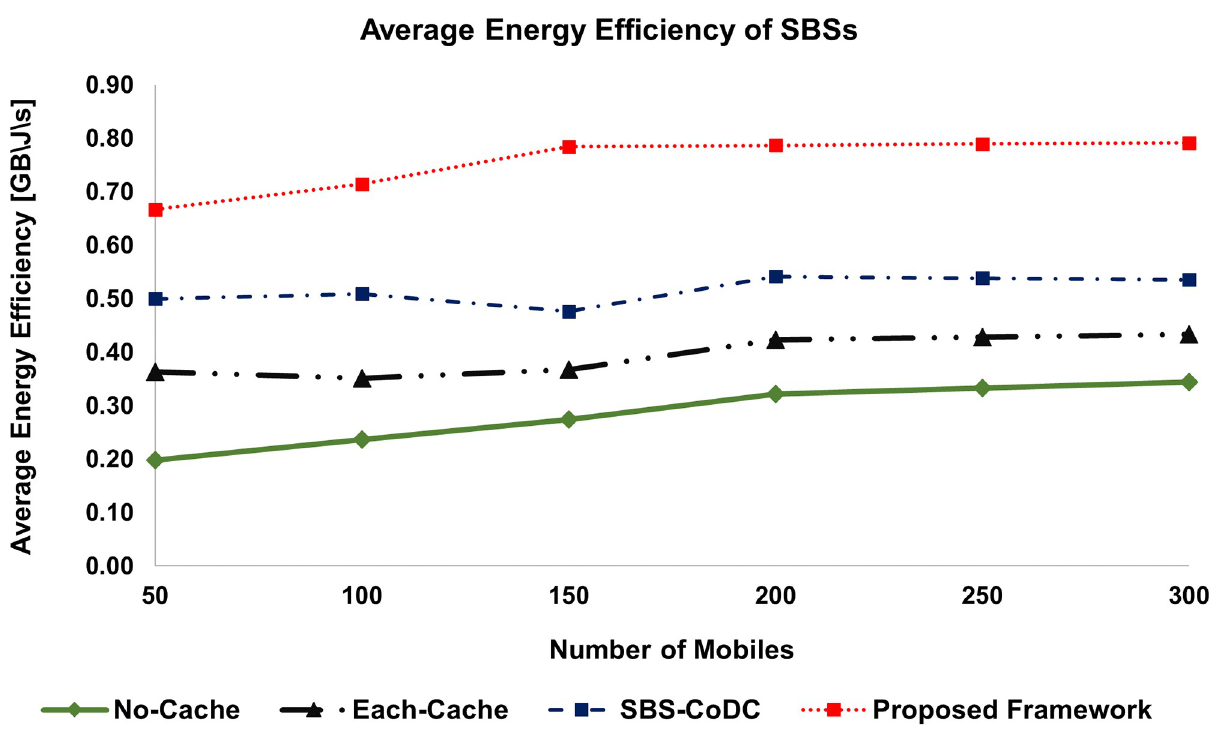
Fig 11. Comparison average EE of SBSs among existing schemes.